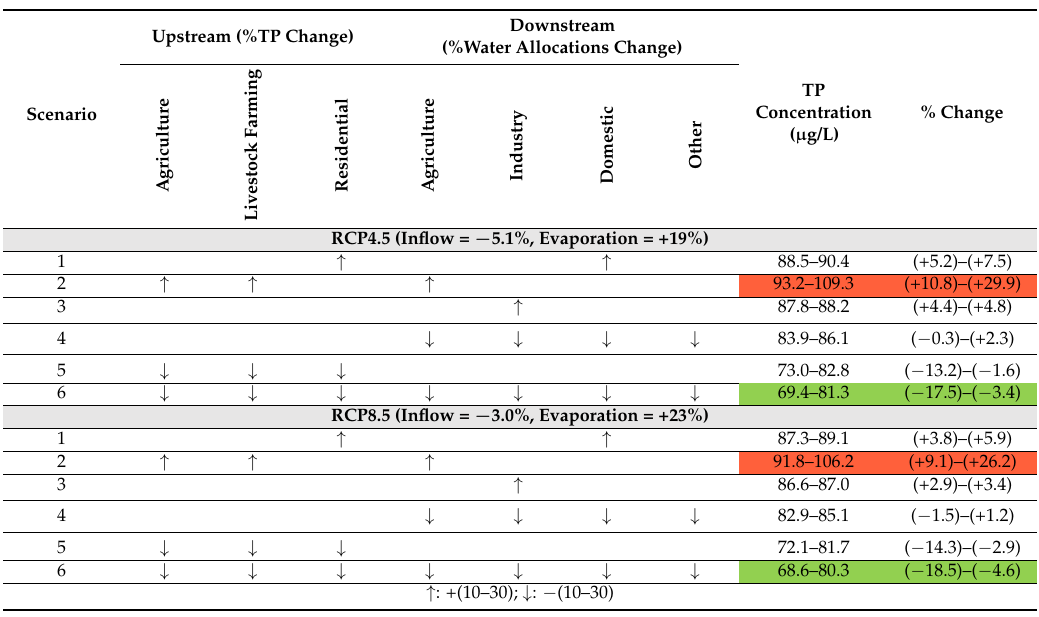
Table 6. The average annual TP concentration in the reservoir under climate change and TP loading